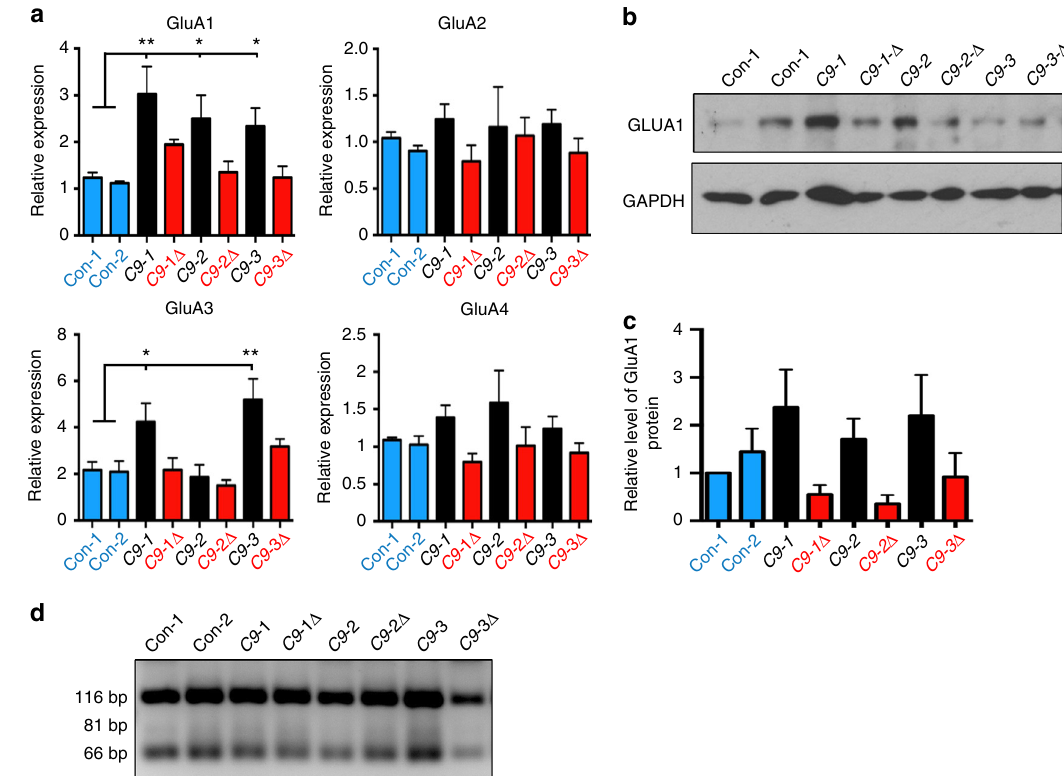
Fig. 5 The C9ORF72 mutation is associated with increased expression of GluA1 AMPAR subunits. a Relative mRNA expression of AMPAR subunits in all cultures examined at week 3 after differentiation (data represented as mean ± s.e.m., Con-1, N = 5; Con-2, N = 6; C9-1, N = 8; C9-1 Δ , N = 4; C9-2, N = 7; C9-2 Δ , N = 6; C9-3, N = 7; C9-3 Δ , N = 6). Statistical comparisons; one-way ANOVA with uncorrected Fisher ’ s LSD. Signi fi cant p -values for GluA1 C9-1 vs. Con-1: 0.0039, C9-2 vs. Con-1: 0.0360, C9-3 vs. Con-1: 0.0503, C9-1 vs. Con-2: 0.0130, C9-2 vs. Con-2: 0.0163, C9-3 vs. Con-2: 0.0385. p -values for GluA3 C9-1 vs. Con-1: 0.0218, C9-3 vs. Con-1: 0.0017, C9-1 vs. Con-2: 0.0256, C9-3 vs. Con-2: 0.0024. b Representative immunoblot showing elevated levels of GluA1 in C9ORF72 mutant MNs. c Quanti fi cation of GluA1 protein level in C9ORF72 mutant MNs (data represented as mean ± s.e.m., Con-1, N = 3; Con-2, N = 5; C9-1, N = 6; C9-1 Δ , N = 3; C9-2, N = 3; C9-2 Δ , N = 3; C9-3, N = 6; C9-3 Δ , N = 6). d Representative gel picture showing ef fi cient GluA2 Q → R RNA editing in week 3 cultures across all the lines. Ef fi cient GluA2 RNA editing results in RFLP amplicons of 116 and 66 bp, see also Supplementary Fig. 4B. Band at 81 bp would be observed if inef fi cient editing of the GluA2 subunit was